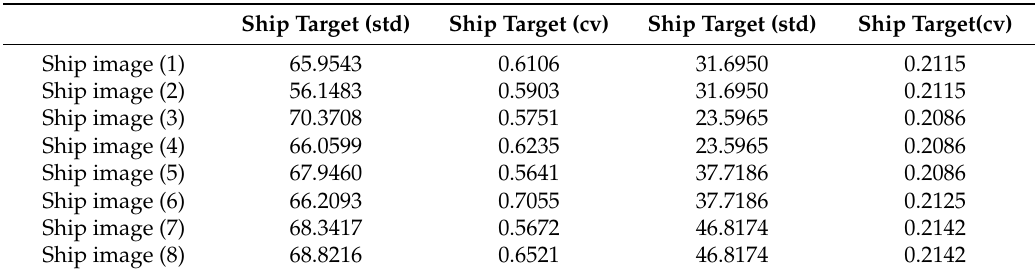
Table 1. Ship image spatial di ff erence eigenvalues.